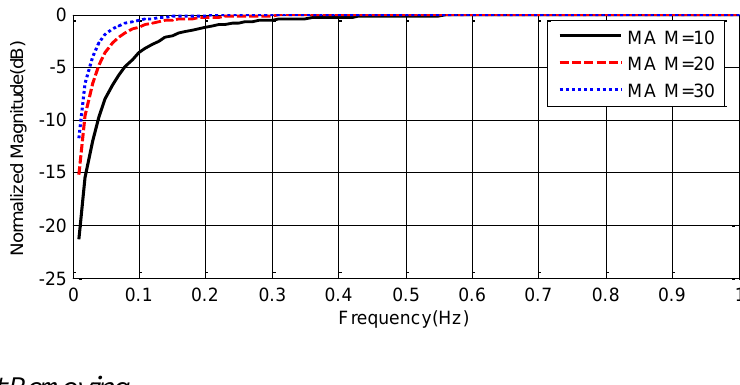
Figure 4. Frequency response of the moving averaging filter with different window lengths, M